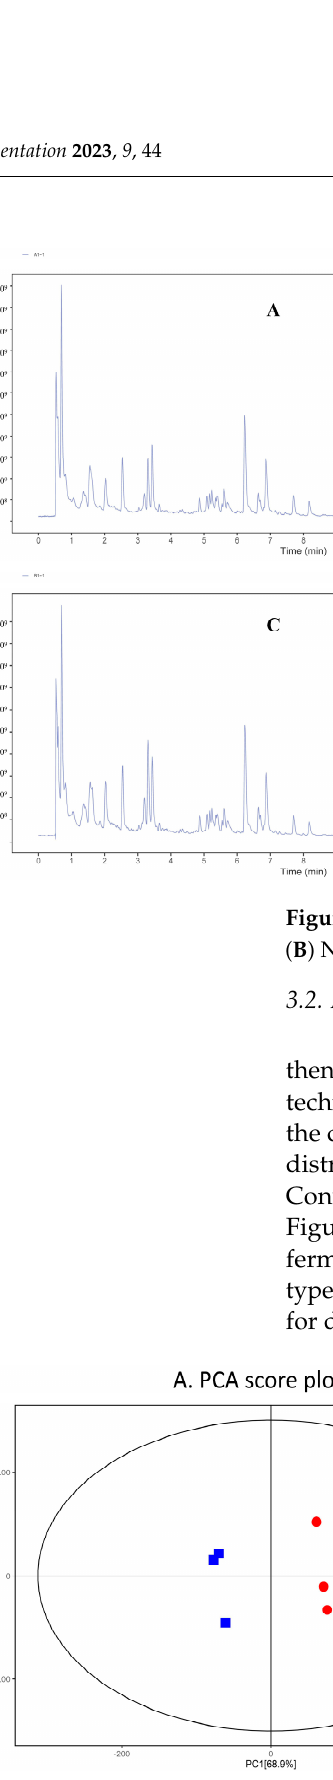
score plot; ( B ) OPLS-DA score